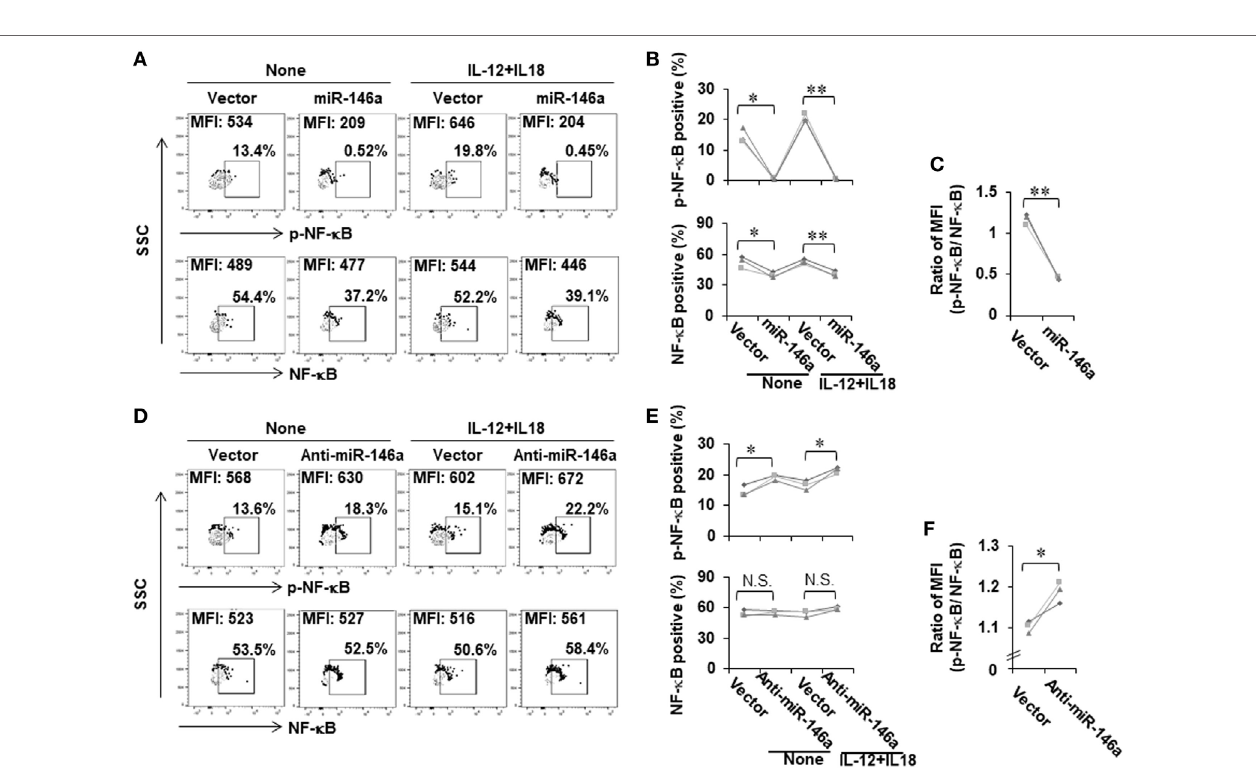
FigUre 3 | NF- κ B signaling is negatively regulated by miR-146a in resting and cytokine-stimulated human NK cells. NK-92 cells expressing miR-146a or anti-mIR-146a were cultured in medium without IL-2 for 24 h, followed by treatment with or without IL-12 (10 ng/mL) plus IL-18 (100 ng/mL) for an additional 24 h. Cells were harvested to stain with antibodies, followed by flow cytometric analysis. The NF- κ B p65 protein levels and its phosphorylation were measured by flow cytometric analysis (a,B,D,e) ( n = 3). The ratio of p-NF- κ B to NF- κ B was calculated based on mean fluorescence intensity (MFI) of each molecule (c,F) ( n = 3). * p < 0.05; ** p < 0.01. Error bars represent